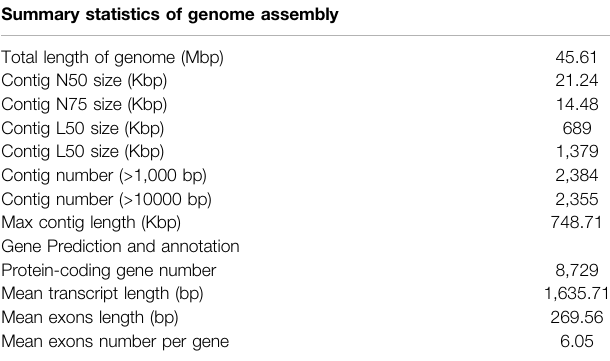
TABLE 1 | Summary statistics of genome assemblies of C. irritans . Summary statistics of genome assembly